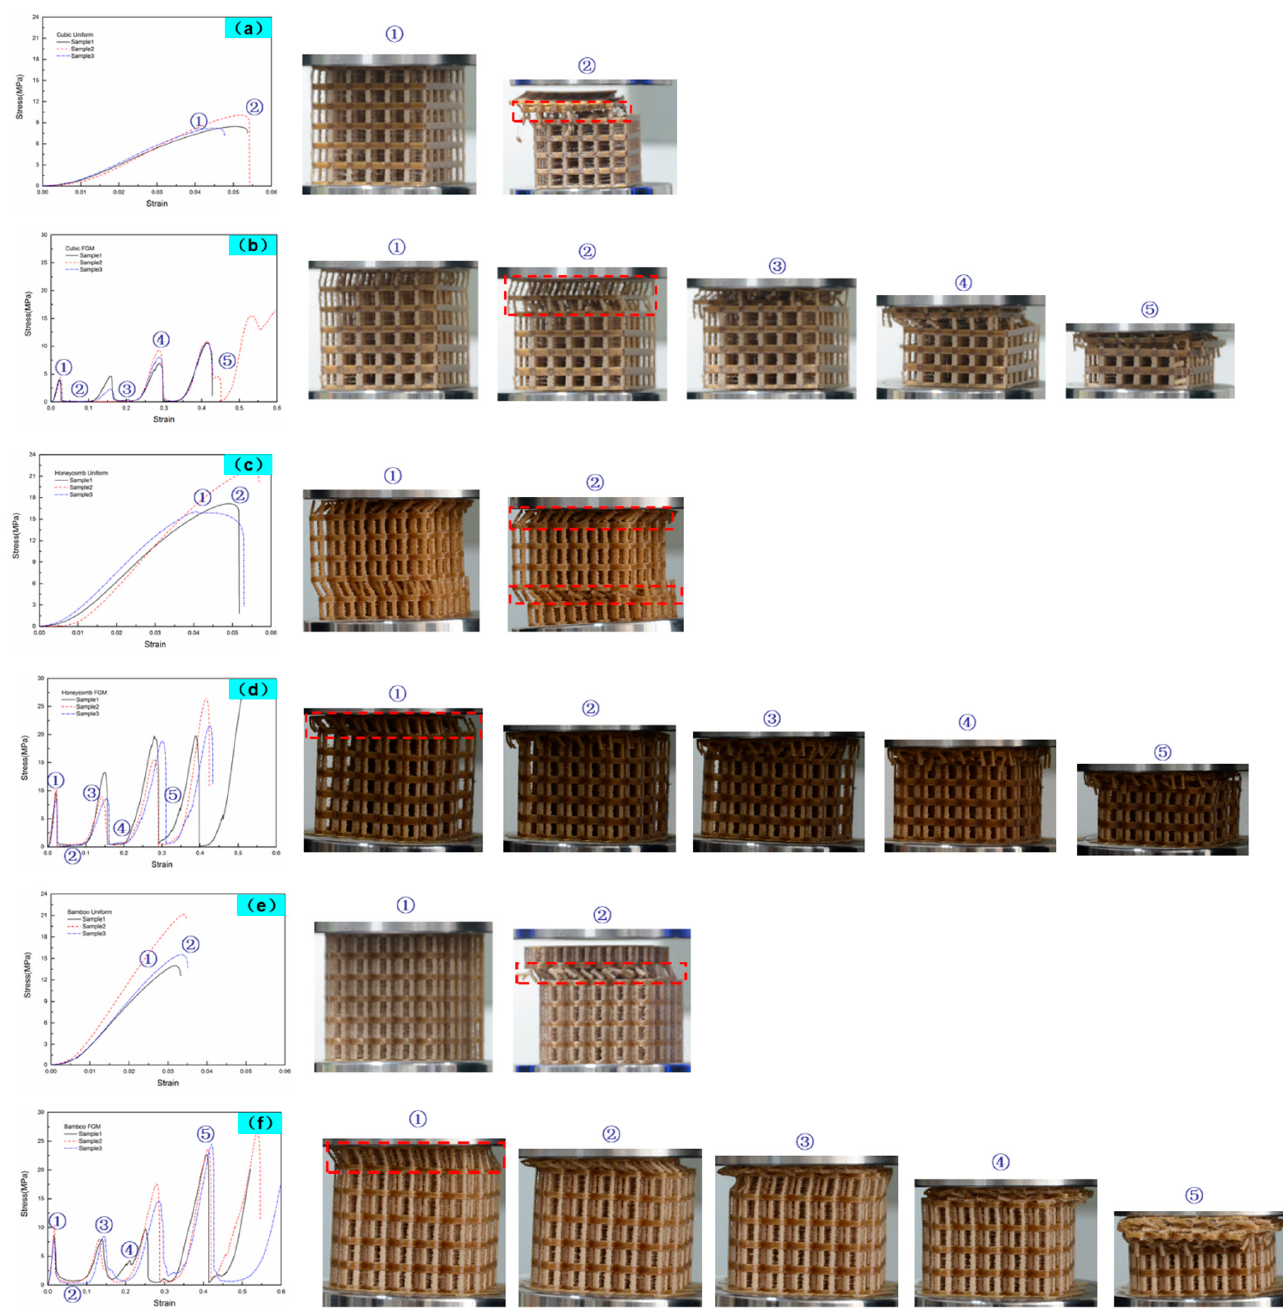
Figure 6. Deformation process of lattice structures: ( a ) cubic uniform, ( b ) cubic FGM, ( c ) honeycomb uniform, ( d ) honeycomb FGM, ( e ) bamboo uniform and ( f ) bamboo FGM.